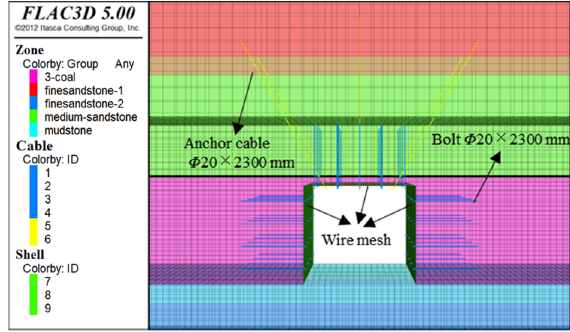
Figure 8. Transport roadway public support part.